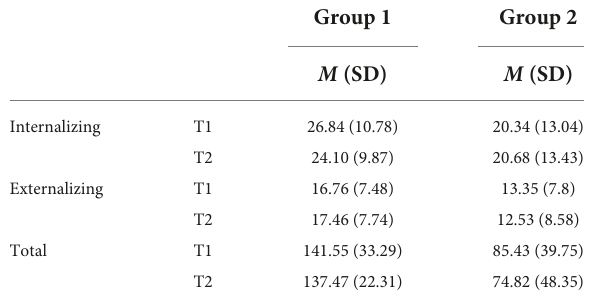
TABLE 2 Average scores and standard deviations of the Child Behavior Cheklist (CBCL) internalizing and externalizing